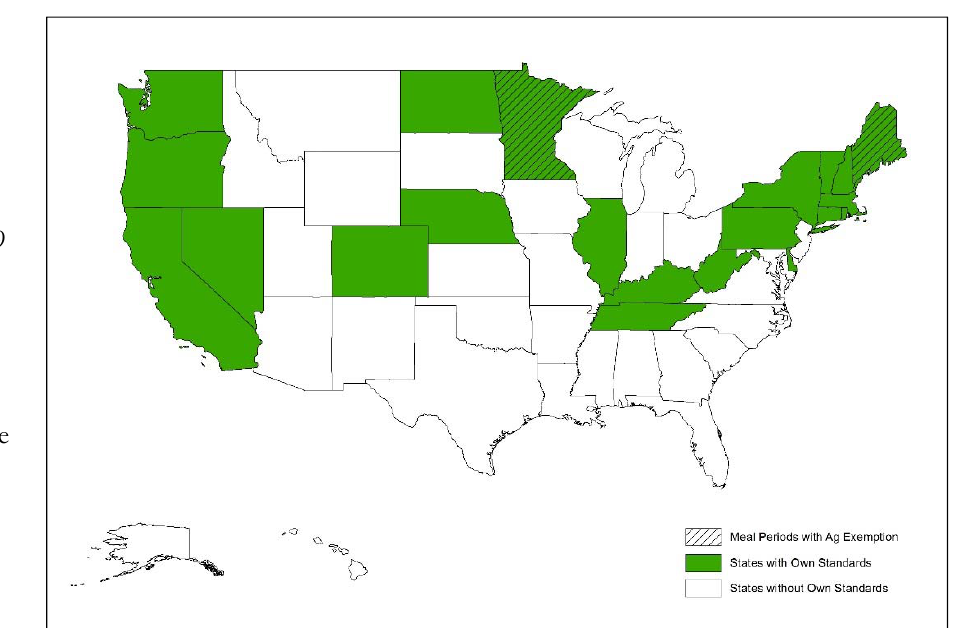
Figure 4. Meal Period Agricultural Exceptions by State,